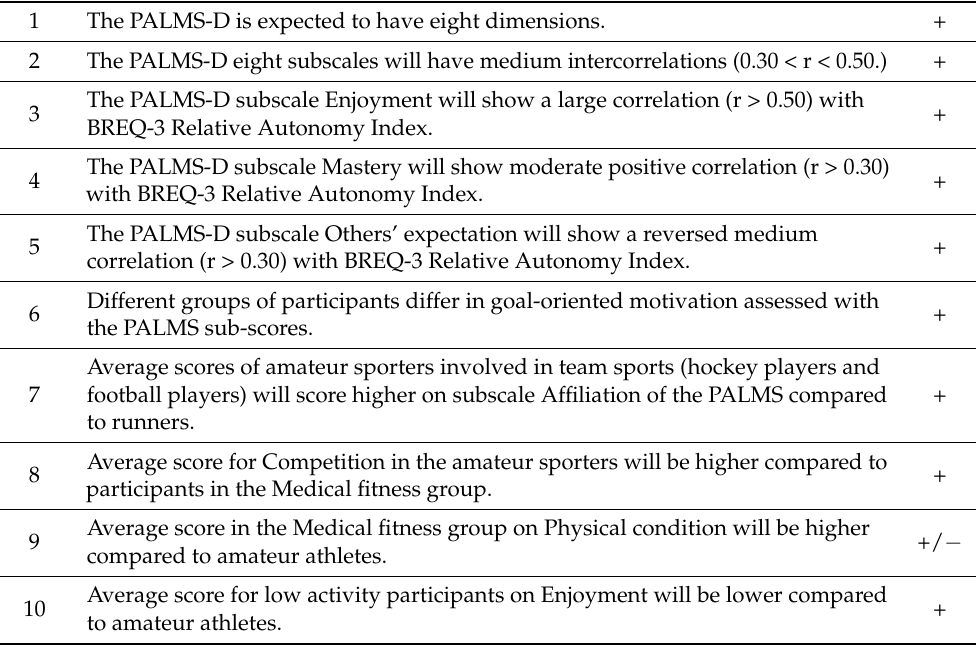
Table 1. A priori formulated hypothesis for construct testing (confirmation/rejection = +/ − ).